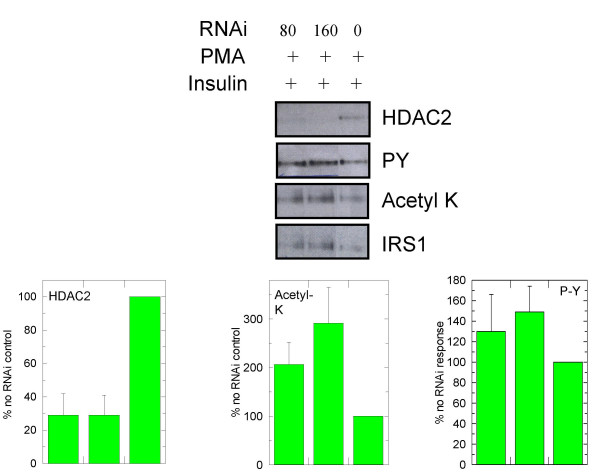
Specific inhibition of HDAC2 enhances insulin signalling. MCF-7 cells were transfected with short inhibitory RNA oligonucleotides (80 and 160 pmol as indicated) for four hours and cultured a further 48 hours prior to treatment with PMA (10 ng/ml for 4 hours) and stimulation with insulin (100 nM) for 10 minutes. IRS-1 was immunoprecipitated and western blotted for the presence of HDAC2, phosphotyrosine, acetyl lysine and IRS-1 itself. The graphs show average data (± SEM) for 3–5 independent experiments, normalised to the insulin response alone. P-Y: phosphotyrosine.